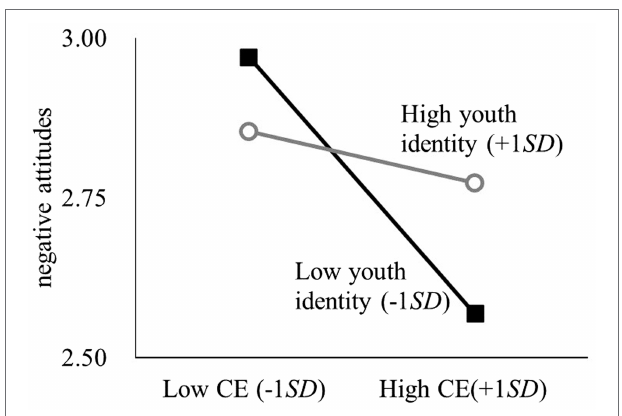
FIGURE 1 | The interaction between youth identity and contact experience on negative attitudes. CE, contact